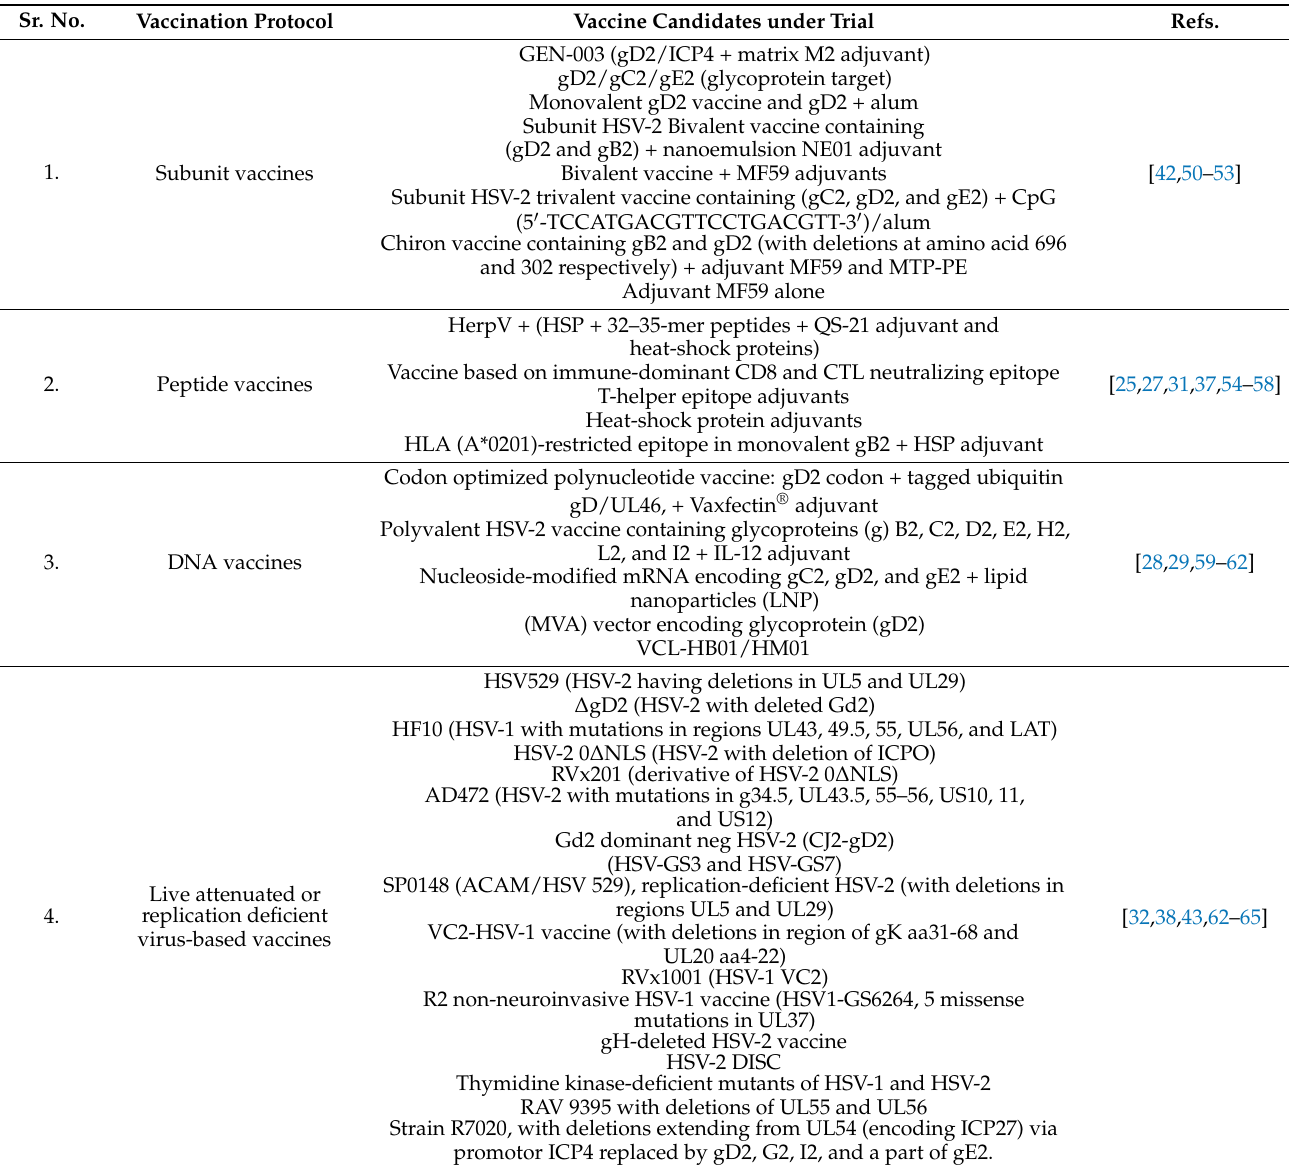
Table 1. An update on current vaccine candidates against